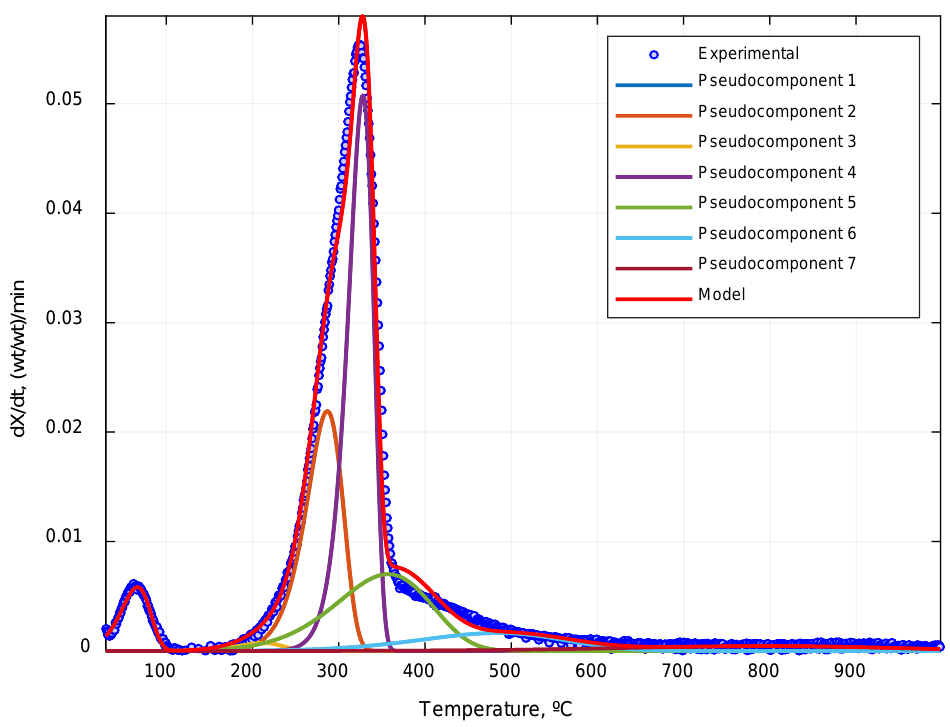
Figure 7. Model fitted to the experimental wheat straw DTG curve.